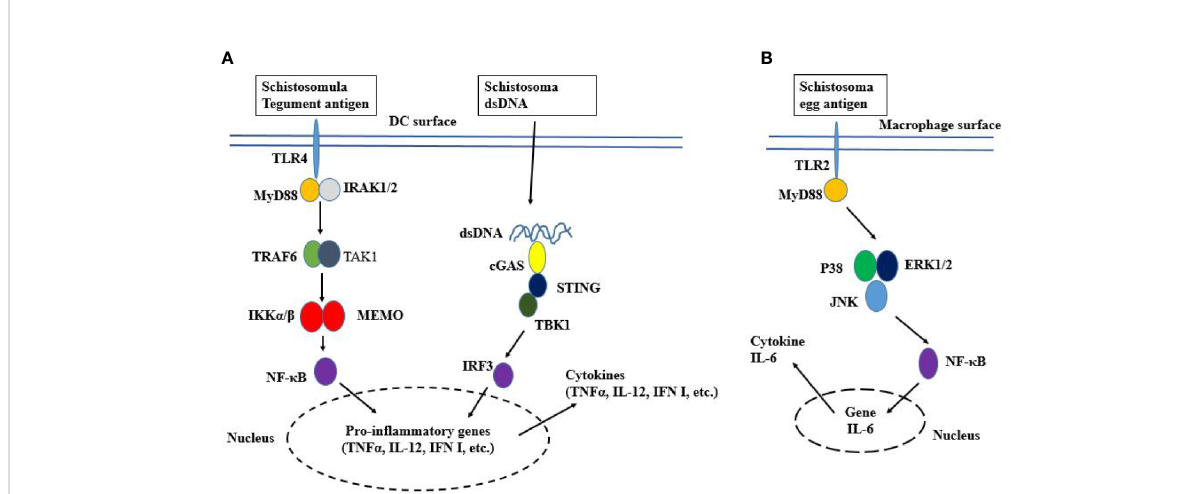
FIGURE 1 Schematic representation of TLR signaling. (A) TLR4 localizes to the cell surface. It is activated by ligand binding, which leads to the dimerization of TLR and the recruitment of TLR domain-containing adaptor proteins. Then MyD88 activates IRAK which induces K63-linked polyubiquitination on TRAF6 itself and TAK1. The TAK1 activation leads to the activation of IKK complex NF- k B and cytokine genes transcription. The worms DNA is sensed by cGAS, resulting in the activation of STING-TBK1-IRF3 signaling and IFN-I response. (B) Egg activated TLR2 recruits MyD88, resulting in the phosphorylation of P38, ERK1/2, and JNK. Thereafter, NF- k B induces the expression of the IL-6